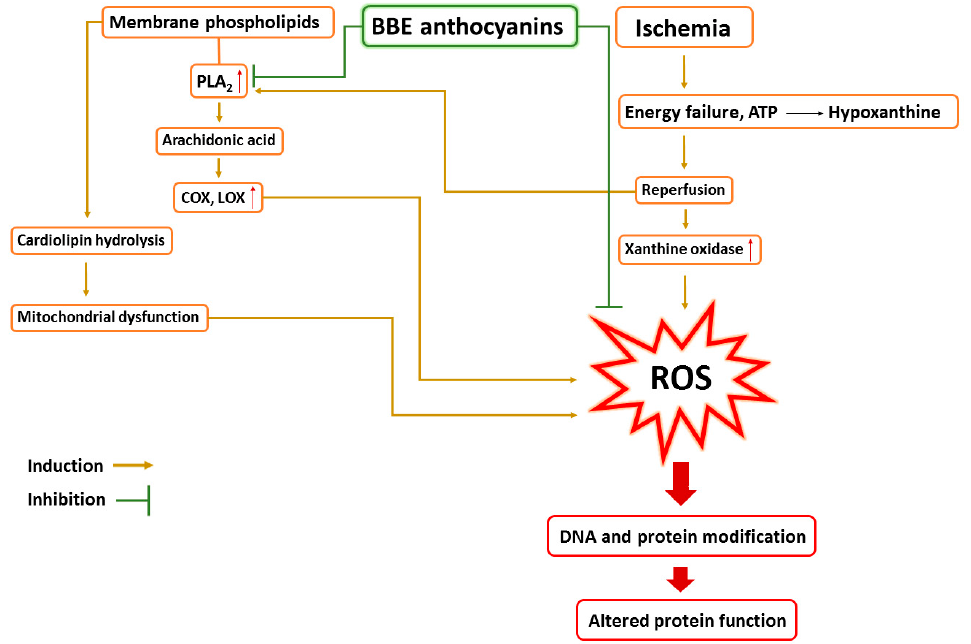
Figure 10. Schematic representation of the role of ischemia ‐ reperfusion in the induction of ROS in liver cells showing the role of PLA2 and the possible protective effect of BBE ’s anthocyanins. PLA2, Phospholipase A2; COX, Cyclooxygenase; LOX, Lipoxygenase; ATP, adenosine triphosphate; ROS, reactive oxygen species.